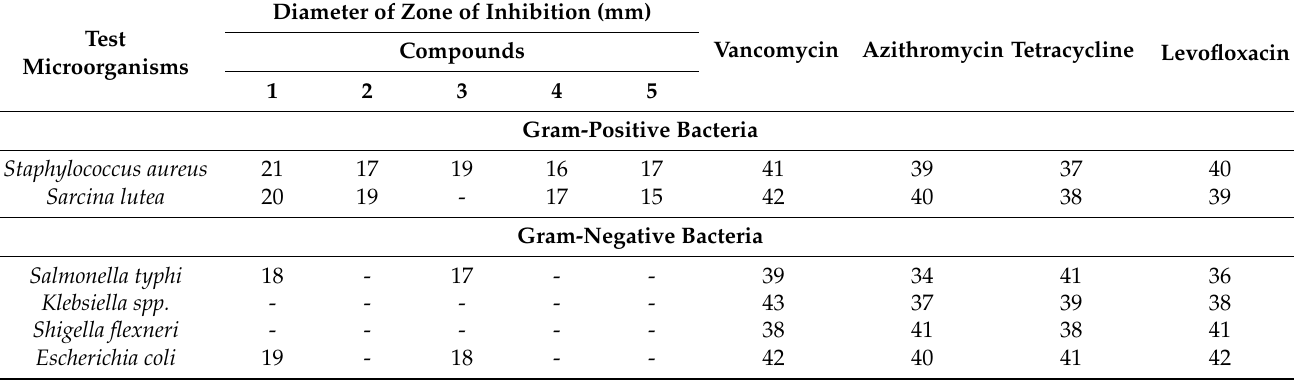
Table 1. Antibacterial Activity of the Isolated